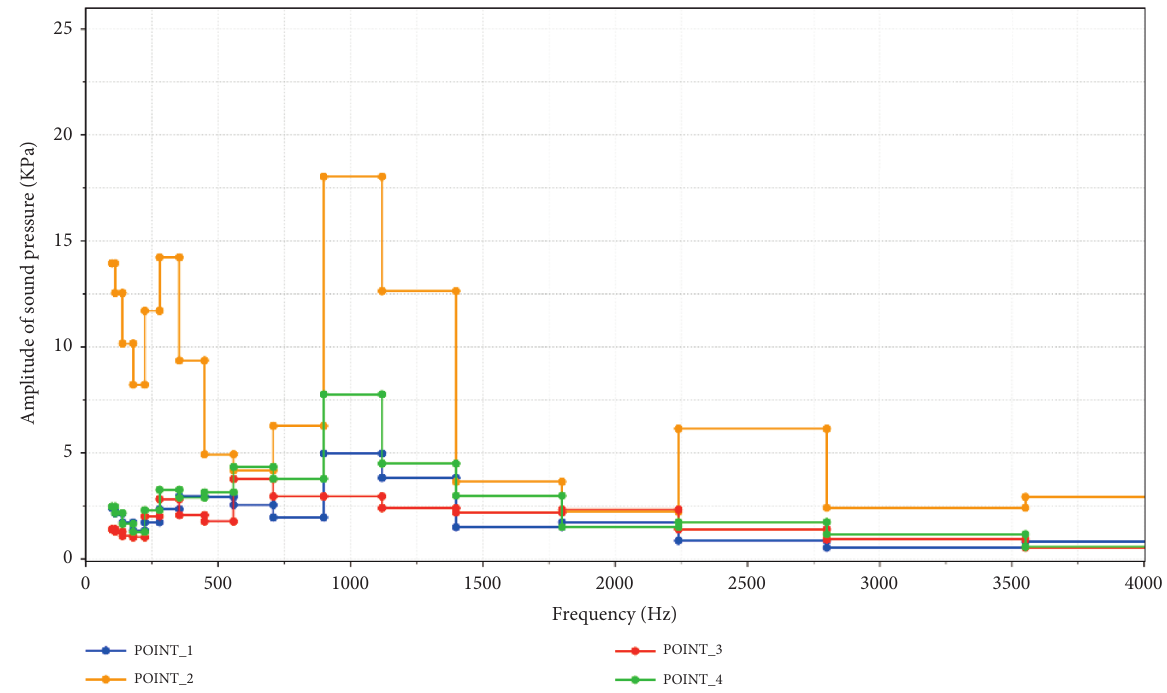
Figure 16: 1/3 octave band curve of P1, P2, P3, and P4.